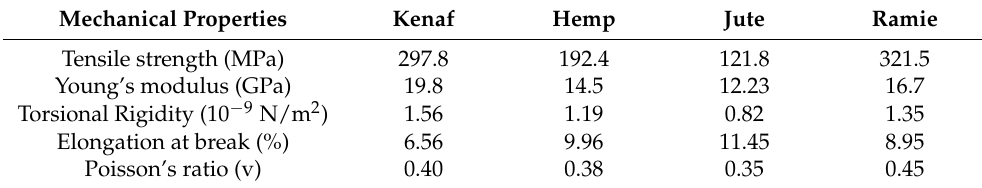
Table 5. Mechanical properties of natural lignocellulosic fibers.